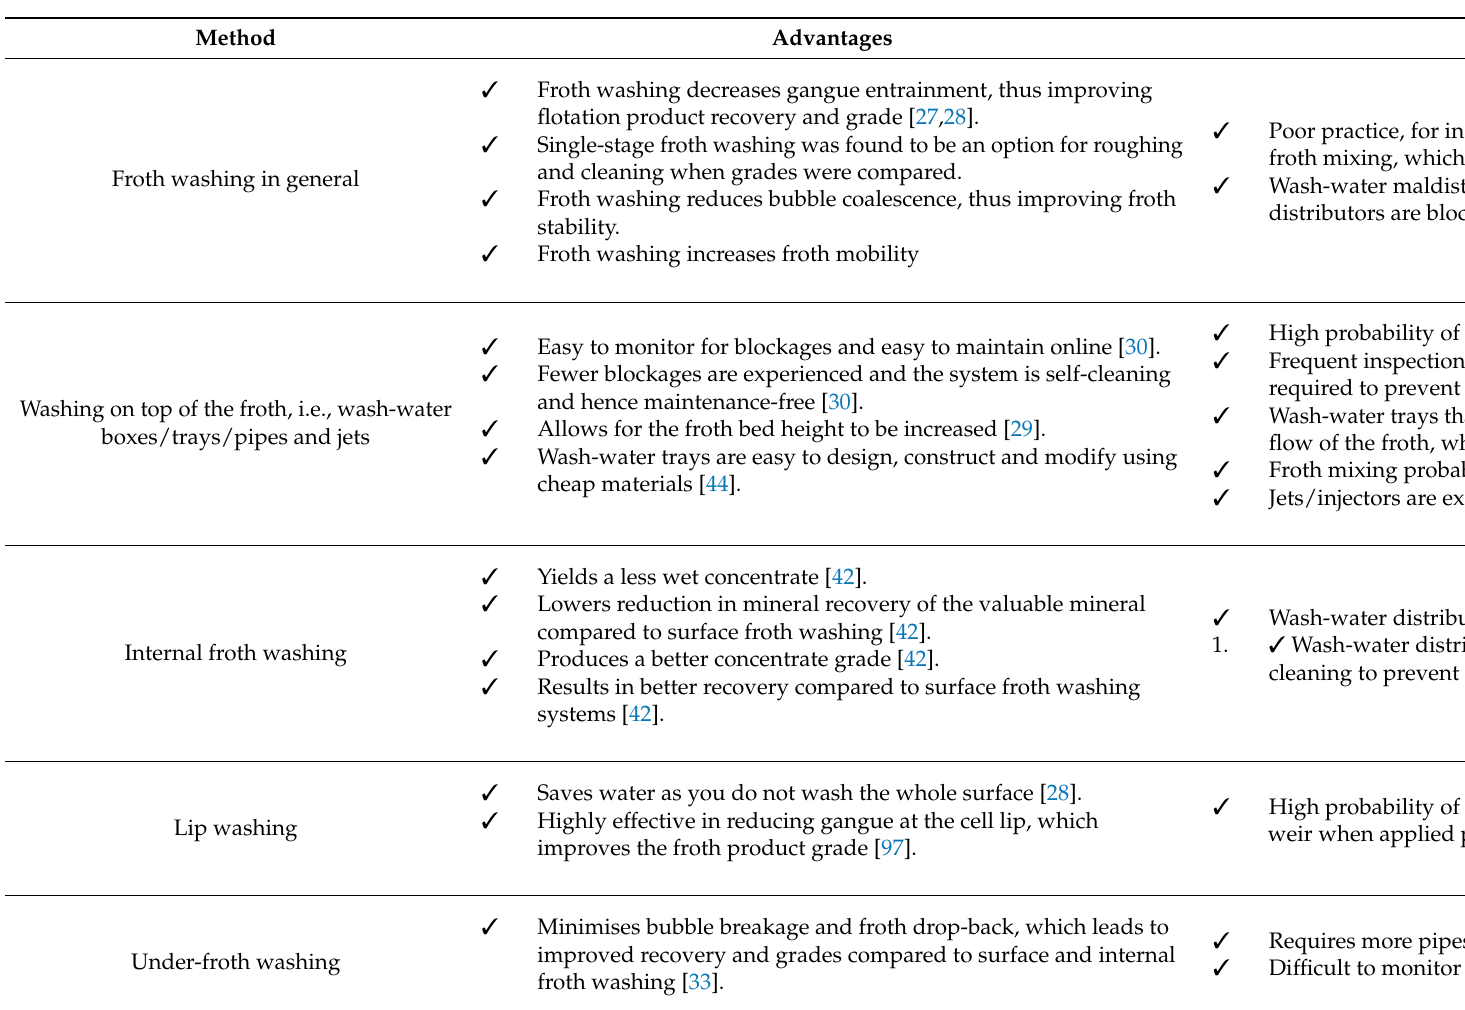
Table 3. Advantages and disadvantages of froth